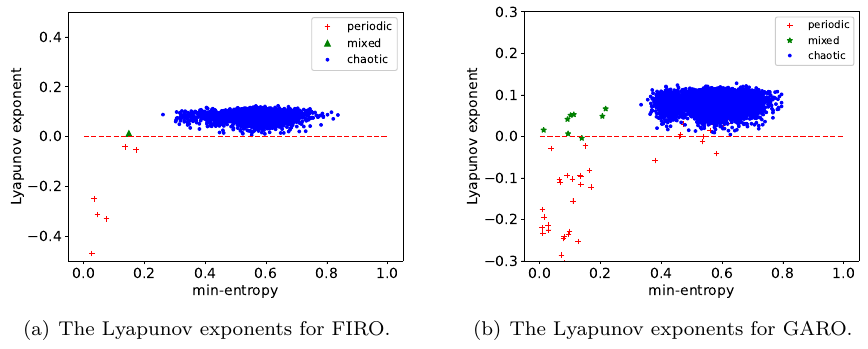
Figure 9: The Lyapunov exponents for FIRO and GARO with periodic, mixed and chaotic